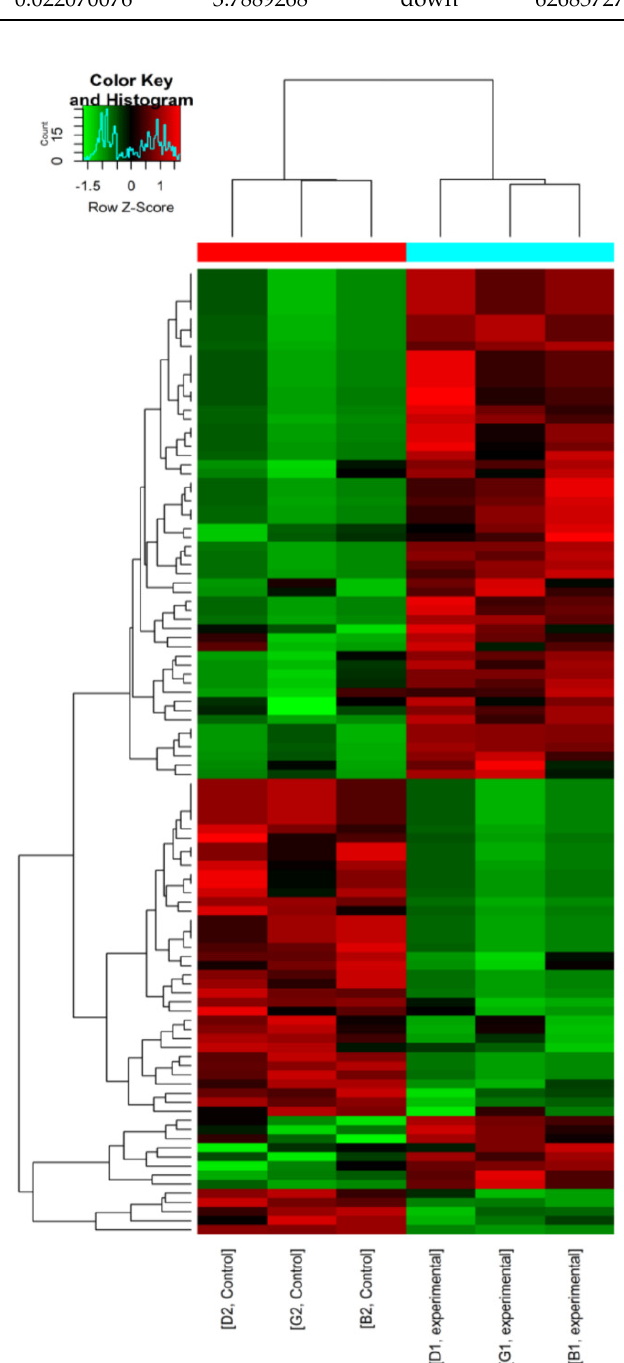
Figure 3. Hierarchical cluster analysis chart of the 106 differentially expressed circRNAs; red repre- sents that the expression level is relatively high, green represents relatively low expression. B1, D1, G1: cancer tissues, B2, D2, G2: adjacent normal tissues.